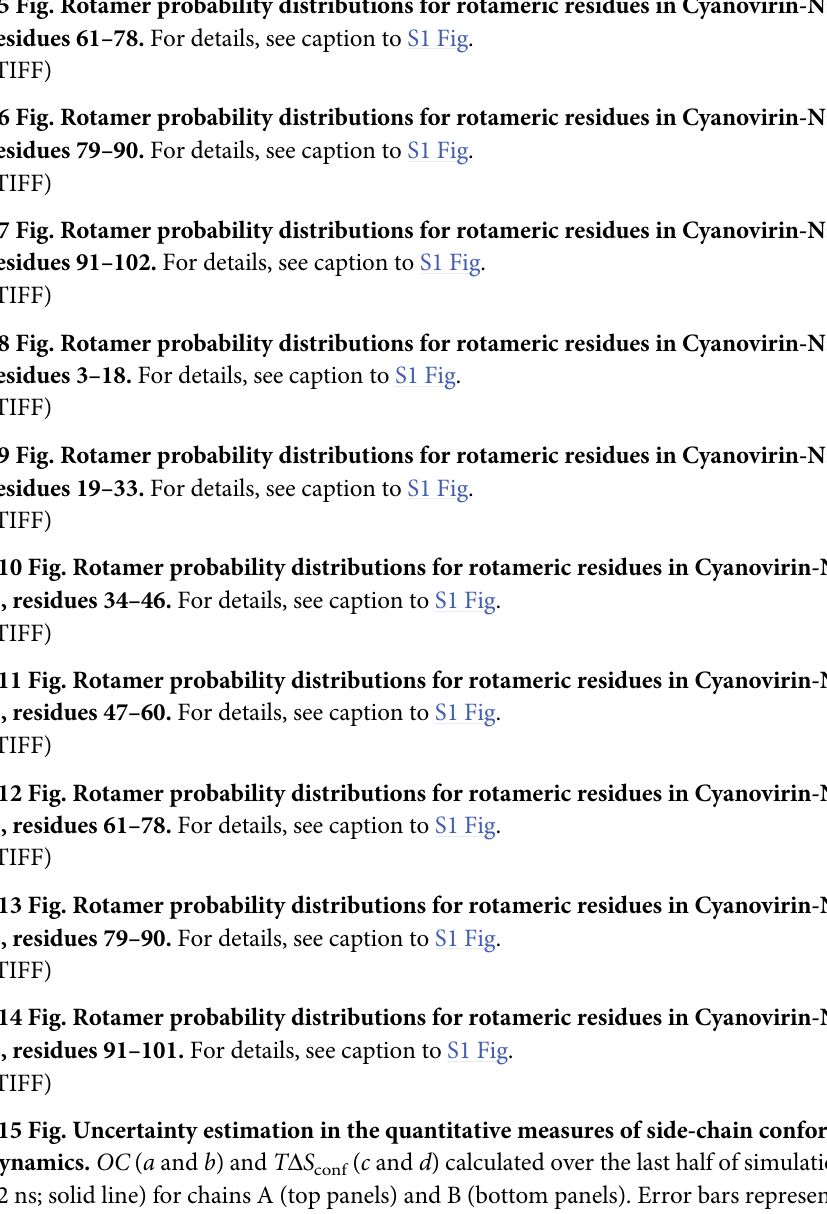
S5 Fig. Rotamer probability distributions for rotameric residues in Cyanovirin-N: chain A, residues 61–78. For details, see caption to S1 Fig. (TIFF) S6 Fig. Rotamer probability distributions for rotameric residues in Cyanovirin-N: chain A, residues 79–90. For details, see caption to S1 Fig. (TIFF) S7 Fig. Rotamer probability distributions for rotameric residues in Cyanovirin-N: chain A, residues 91–102. For details, see caption to S1 Fig. (TIFF) S8 Fig. Rotamer probability distributions for rotameric residues in Cyanovirin-N: chain B, residues 3–18. For details, see caption to S1 Fig. (TIFF) S9 Fig. Rotamer probability distributions for rotameric residues in Cyanovirin-N: chain B, residues 19–33. For details, see caption to S1 Fig. (TIFF) S10 Fig. Rotamer probability distributions for rotameric residues in Cyanovirin-N: chain B, residues 34–46. For details, see caption to S1 Fig. (TIFF) S11 Fig. Rotamer probability distributions for rotameric residues in Cyanovirin-N: chain B, residues 47–60. For details, see caption to S1 Fig. (TIFF) S12 Fig. Rotamer probability distributions for rotameric residues in Cyanovirin-N: chain B, residues 61–78. For details, see caption to S1 Fig. (TIFF) S13 Fig. Rotamer probability distributions for rotameric residues in Cyanovirin-N: chain B, residues 79–90. For details, see caption to S1 Fig. (TIFF) S14 Fig. Rotamer probability distributions for rotameric residues in Cyanovirin-N: chain B, residues 91–101. For details, see caption to S1 Fig. (TIFF) S15 Fig. Uncertainty estimation in the quantitative measures of side-chain conformational dynamics. OC ( a and b ) and T Δ S ( c and d ) calculated over the last half of simulation (16– conf 32 ns; solid line) for chains A (top panels) and B (bottom panels). Error bars represent the uncertainty in OC and T Δ S for each residue. Measurements of these quantities were calcu- conf lated during two equal-length, non-overlapping trajectory segments (16–24 ns and 24–32 ns) and then taken as lower and upper bound estimates. The error bars represent the interval encompassed by these bounds. (TIF) S16 Fig. Residue composition of contacting and non-contacting solvent-exposed residues in CVN. Frequency of residues in the contacting (top panels) and non-contacting (bottom panels) sets of residues in CVN chains A (at left) and B (at right). Residues on the horizontal axis are ordered based upon the number of rotameric states: left (more rotamers) to right (less rotamers) according to the Penultimate Rotamer Library [26]. Ala and Gly do not have